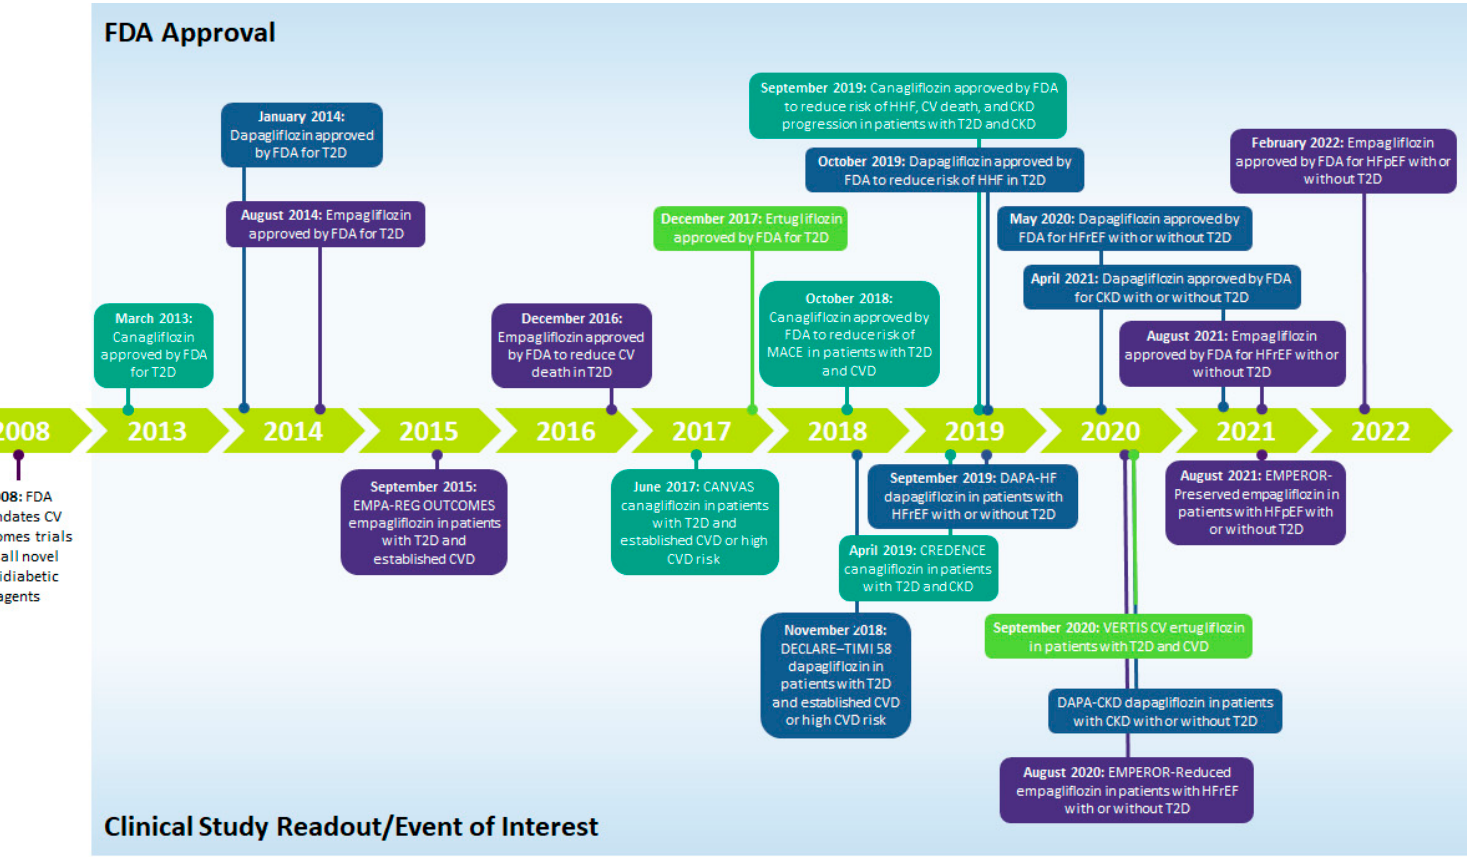
Figure 1. Timeline summarizing the development and approval of SGLT-2is. CKD, chronic kidney disease; CV, cardiovascular; CVD, cardiovascular disease; FDA, US Food and Drug Administration; HF, heart failure; HFpEF, heart failure with preserved ejection fraction; HFrEF, heart failure with reduced ejection fraction; HHF, hospitalization for heart failure; SGLT-2i, sodium-glucose cotransporter-2 inhibitor; T2D, type 2 diabetes.